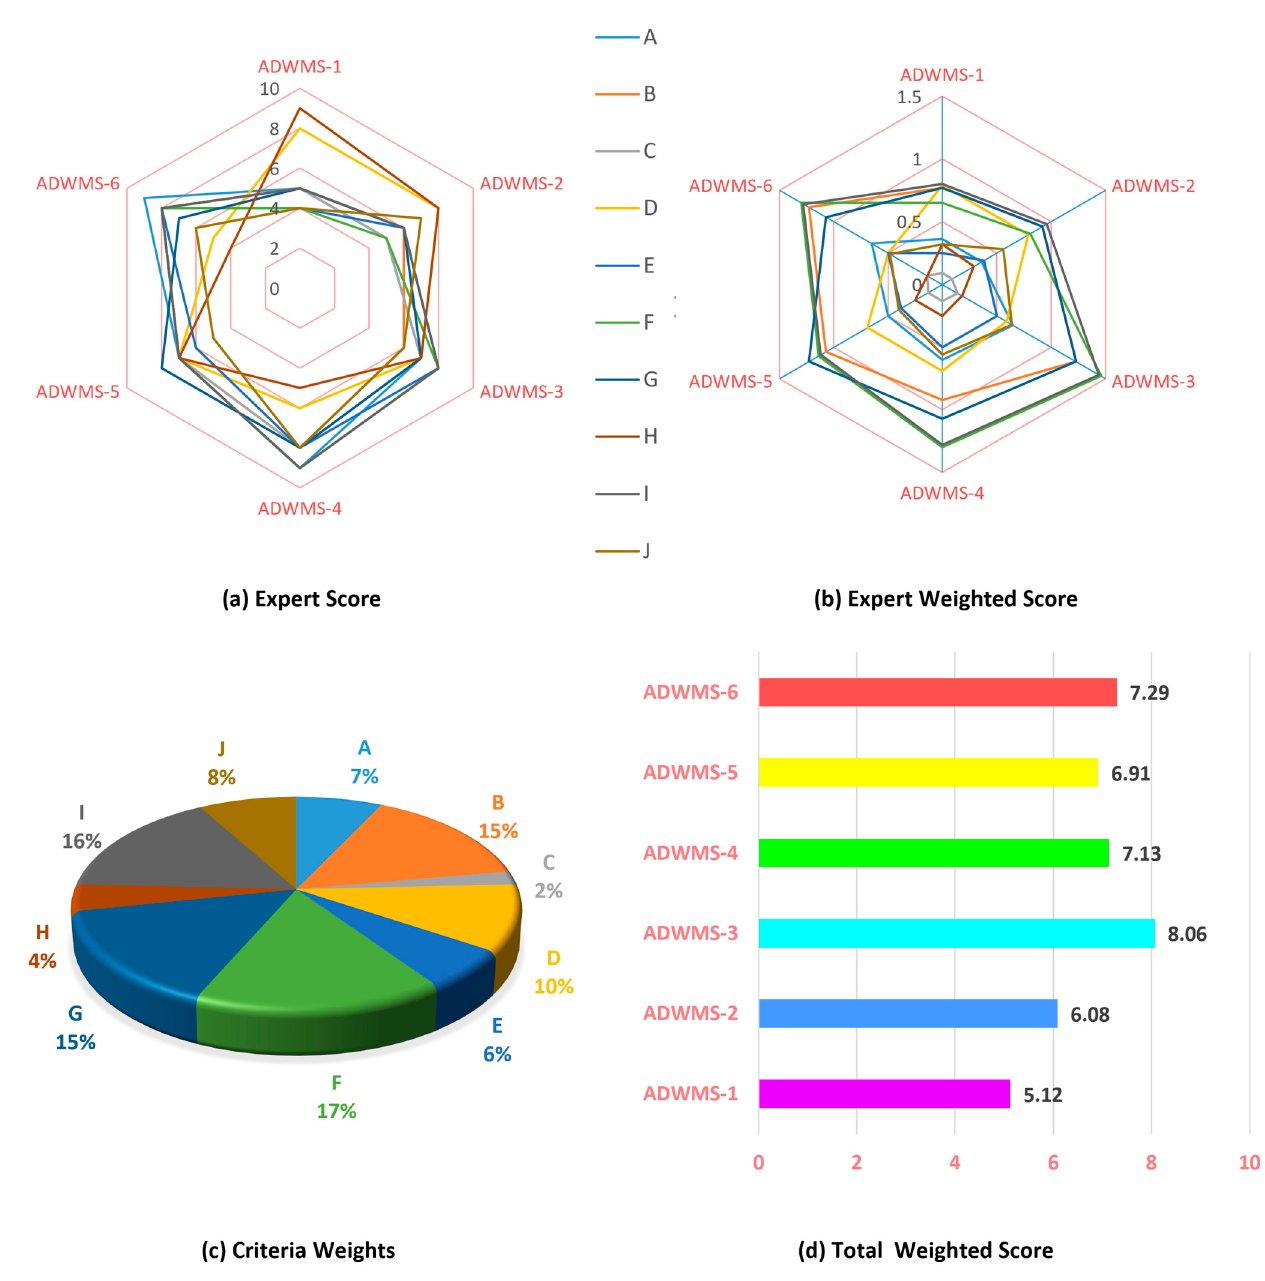
Figure 3. Assessment criteria strategies